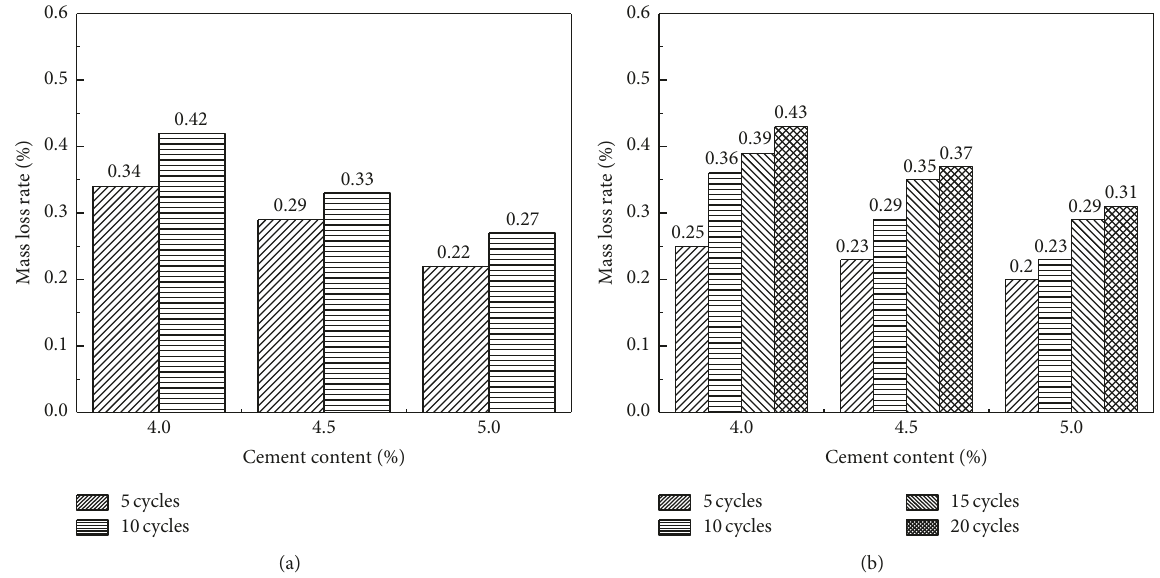
Figure 17: Mass loss rates of the SRBM after different numbers of freeze-thaw cycles: (a) curing time = 28 d; (b) curing time = 90d.